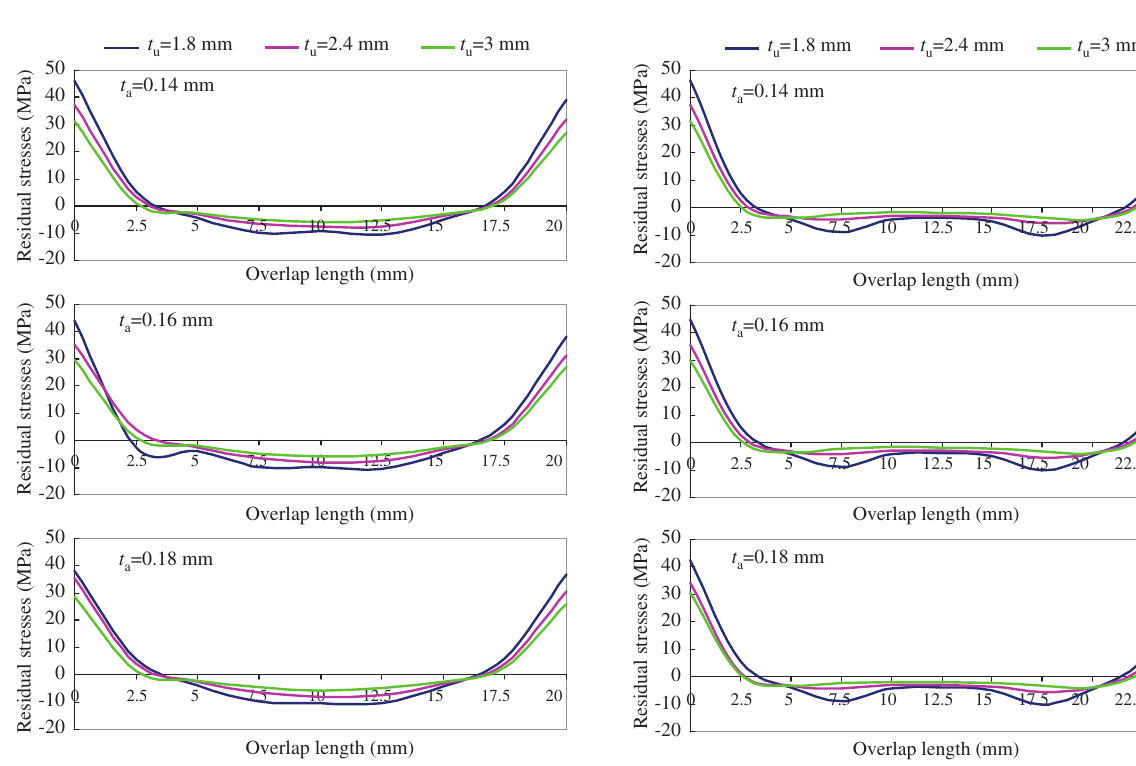
Figure 11 Effect of adherends’ thickness on the residual shear stress for adhesive length of 2 L = 25 mm with different adhesive thickness.